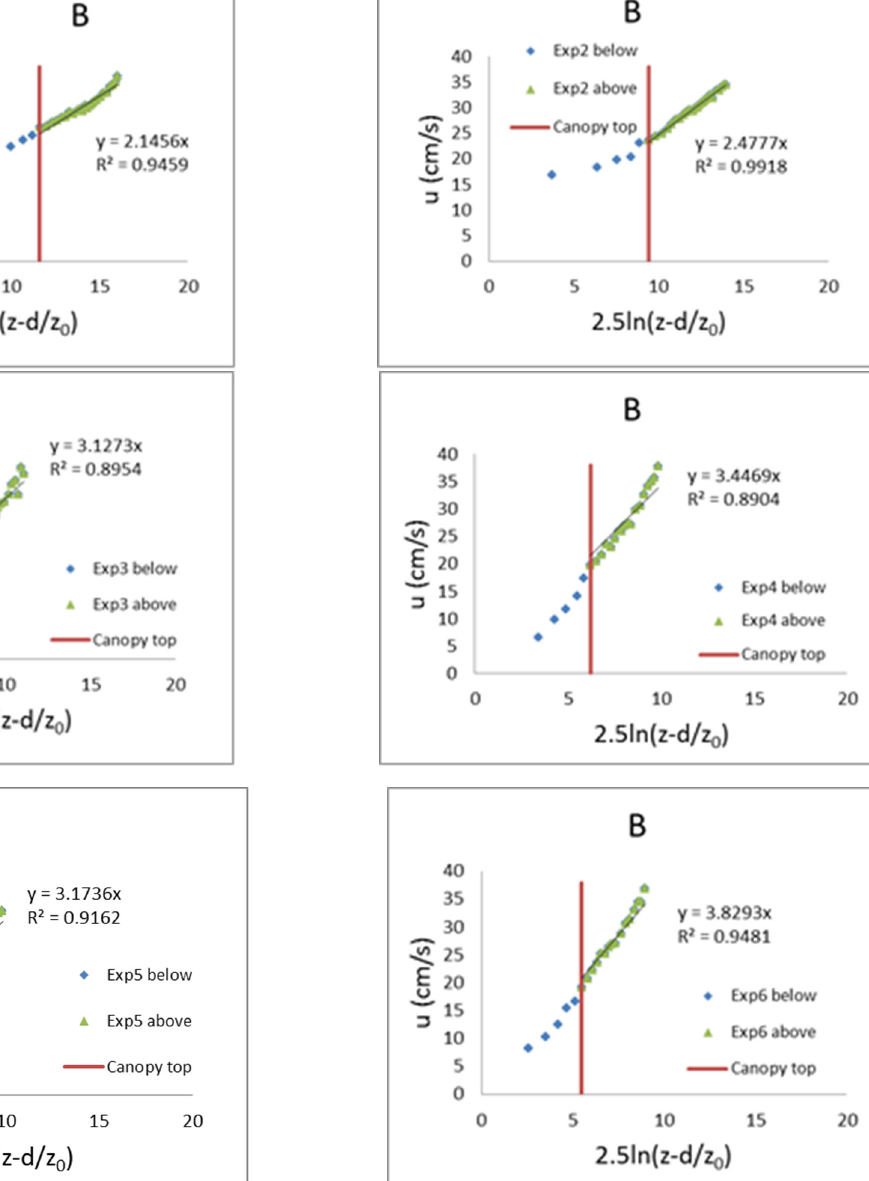
Figure 5. Fitting of Equation (1) to the present data above the canopy top at position B for all experiments following Raupach’s [19] approach.